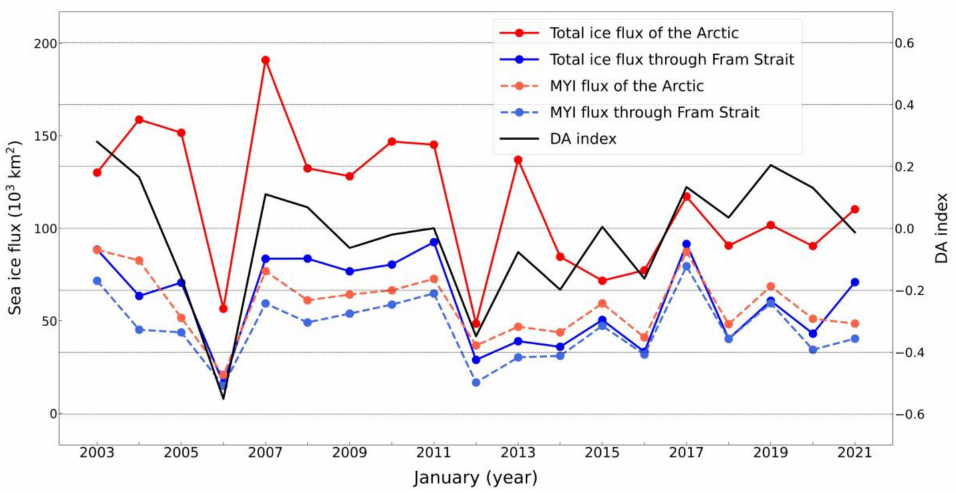
Figure 10. Inter-annual variability of sea ice areal flux and DA index in